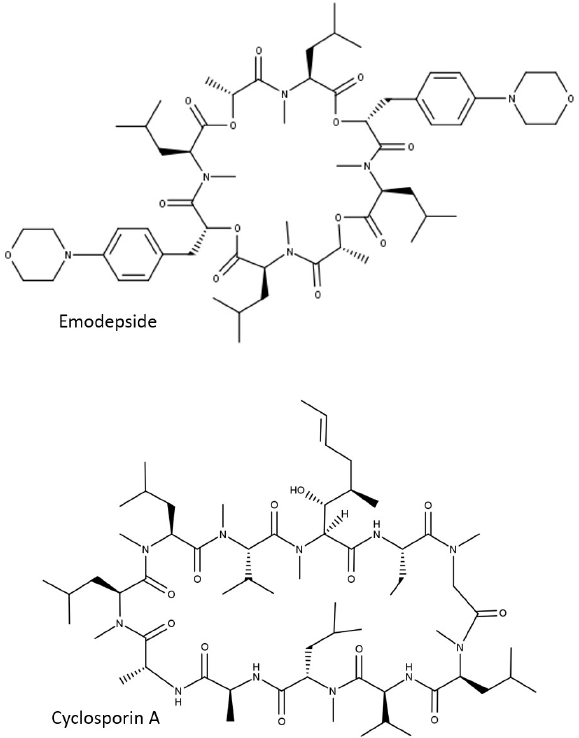
Figure 1. Two-dimensional structures of emodepside and cyclosporin A.